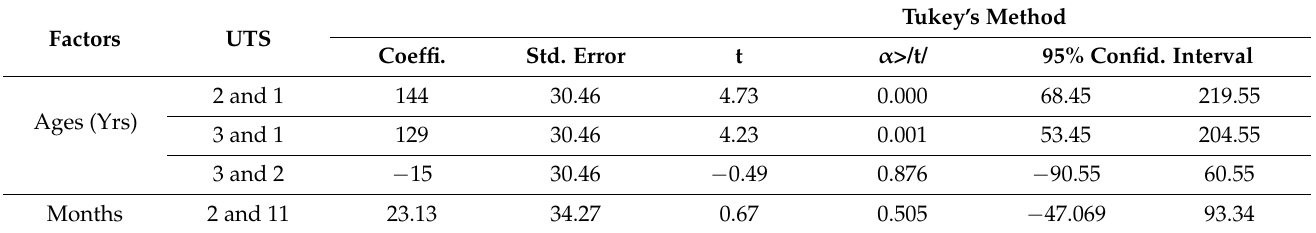
Table 3. Pairwise comparisons of the mean of the tensile strengths for the Kombolch bamboo.